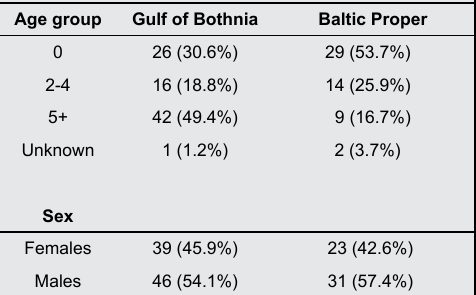
Table 1. Age group, as determined from growth layer counts of canine teeth (Hewer 1964), and sex of grey seals containing food remains collected from the Gulf of Bothnia and the Baltic Proper.